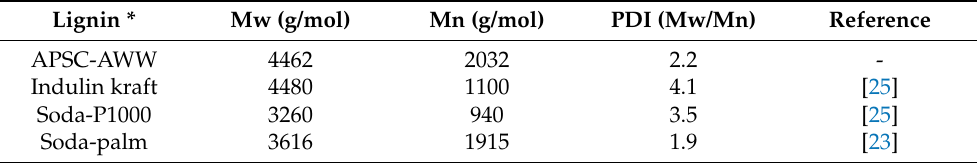
Table 3. Comparison of molecular weight among different